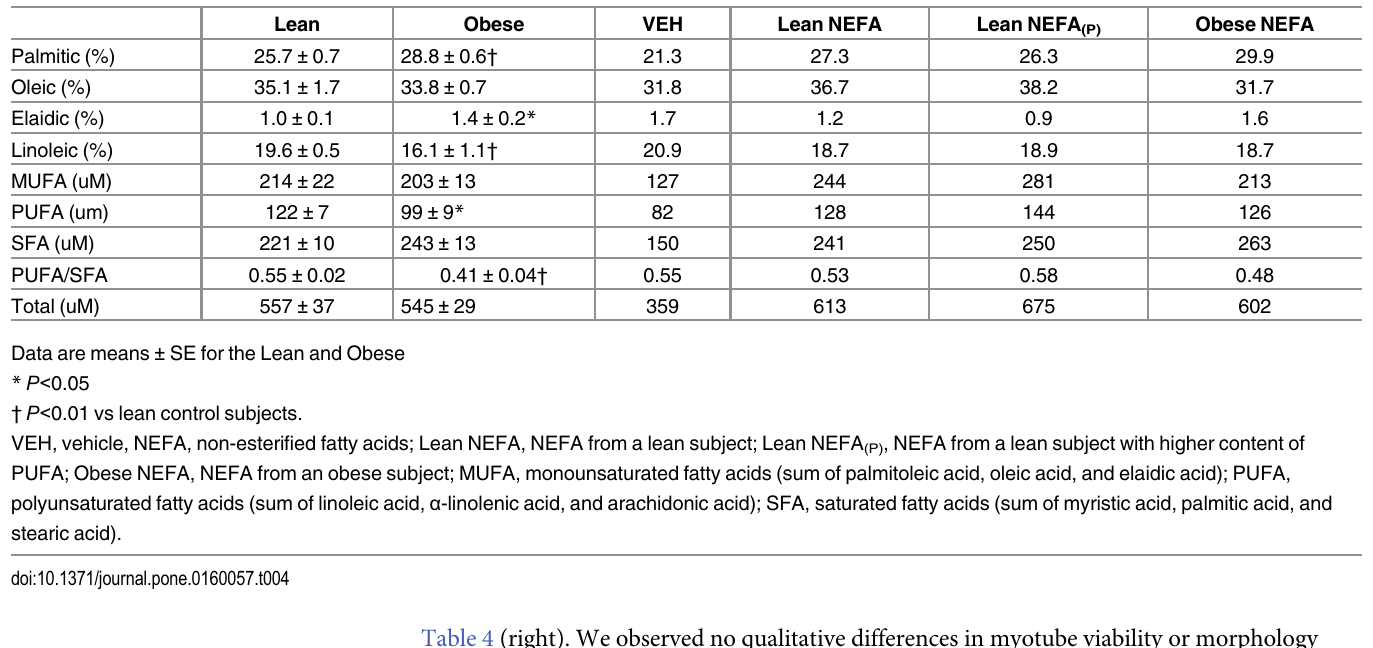
Table 4 (right). We observed no qualitative differences in myotube viability or morphology across the cell culture experiments associated with the three NEFA treatments (S1B Fig). When compared to VEH, basal glucose uptake decreased significantly following the treat- = 2.952; P < 0.05), but there was ment of the myotubes with Lean NEFA or Obese NEFA (F (3,20) no difference between VEH and Lean NEFA or between Obese NEFA and Lean NEFA (P) ( P > 0.05; Fig 2A; left). Further analyses revealed significant effect of the type of NEFA treat- ment on myotybes on GLUT-4 expression (S2A Fig), p-IRS-1 (Tyr895) (S2B Fig) and triacyl- glycerol accumulation (S2C Fig). = 6.994; Each NEFA treatment decreased protein synthesis compared to VEH (F (3,20) P < 0.01), but unlike glucose uptake, the Obese NEFA produced greater suppression of protein synthesis relative to the other NEFA treatments (Fig 2A; right). Treatment with Obese NEFA